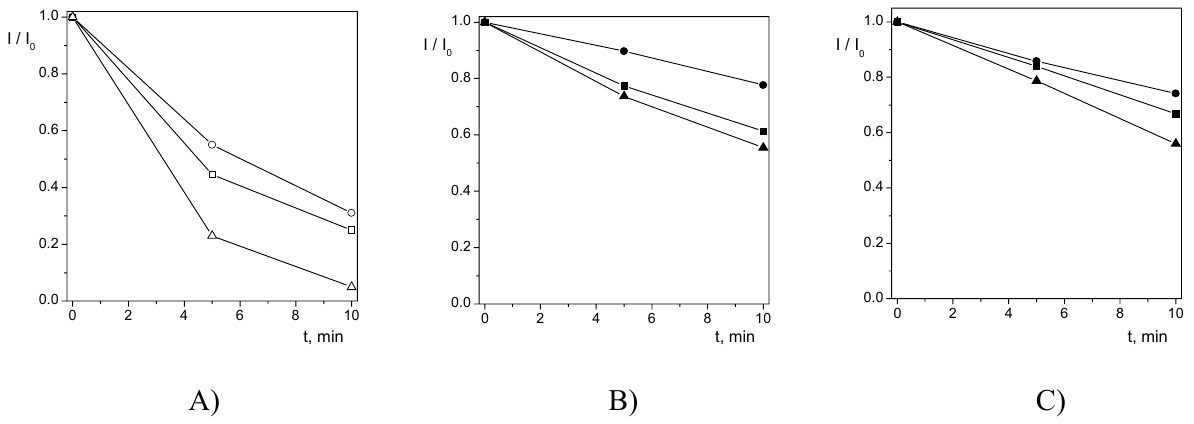
] 3+ signal on the DNA/CPE incubation in the 3 ] 2+ , 1 × 10 -3 mol/l ascorbic acid and 1 × 10 -2 mol/l 2